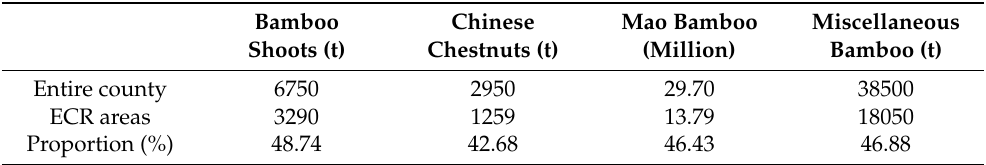
Table 4. Statistics of main ecological products output, in 2015, from Anji County and from its Ecological Conservation Redline (ECR) areas. Bamboo Chinese Mao Bamboo Miscellaneous Shoots (t) Chestnuts (t) (Million) Bamboo (t) Entire county 6750 2950 29.70 38500 ECR areas